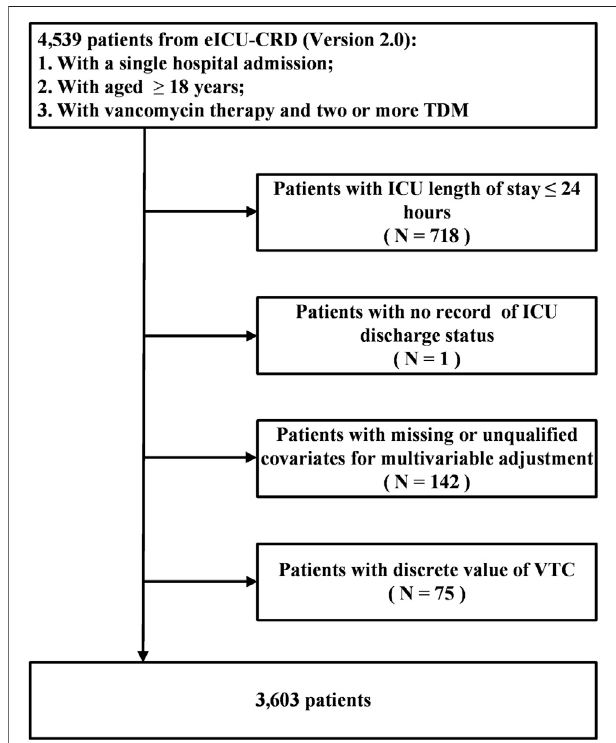
FIGURE 1 | Flow Chart of Participant Selection. Cohort selection and criteria for exclusion, a total of 3,603 patients were included in the analysis. eICU-CRD, eICU Collaborative Research Database; TDM, therapeutic drug monitoring; ICU, intensive care unit; VTC, vancomycin trough